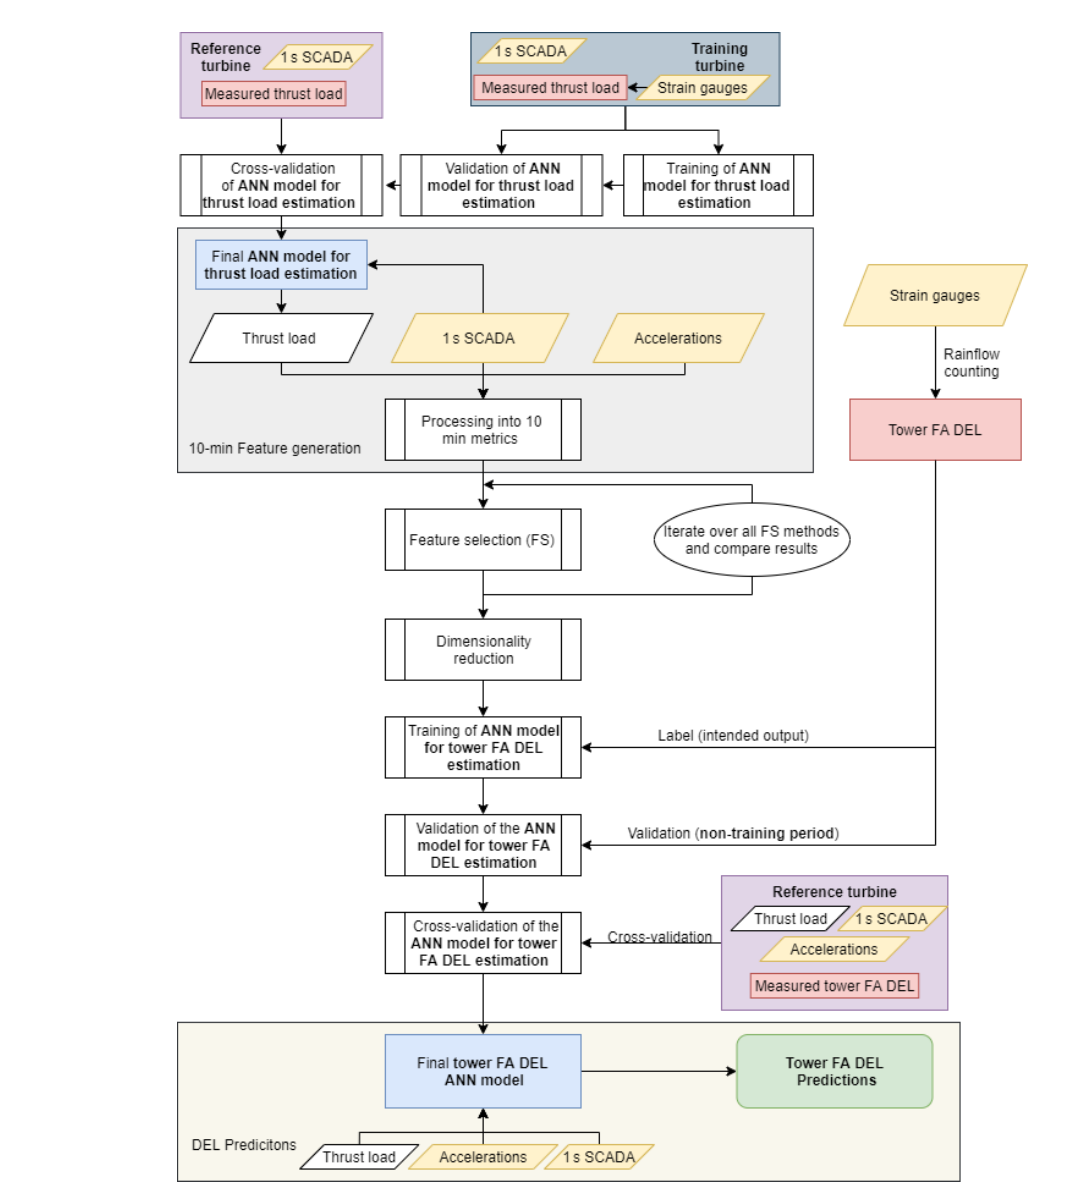
Figure 4. Flowchart representing the methodology’s steps. Yellow highlights the sensors (and data by them captured), red the target, blue the final model and green the final results. Note that for ease of writing, as well as to differentiate from the ANN’s thrust load predictions, the thrust load deduced from the strain gauges is mentioned as the measured thrust